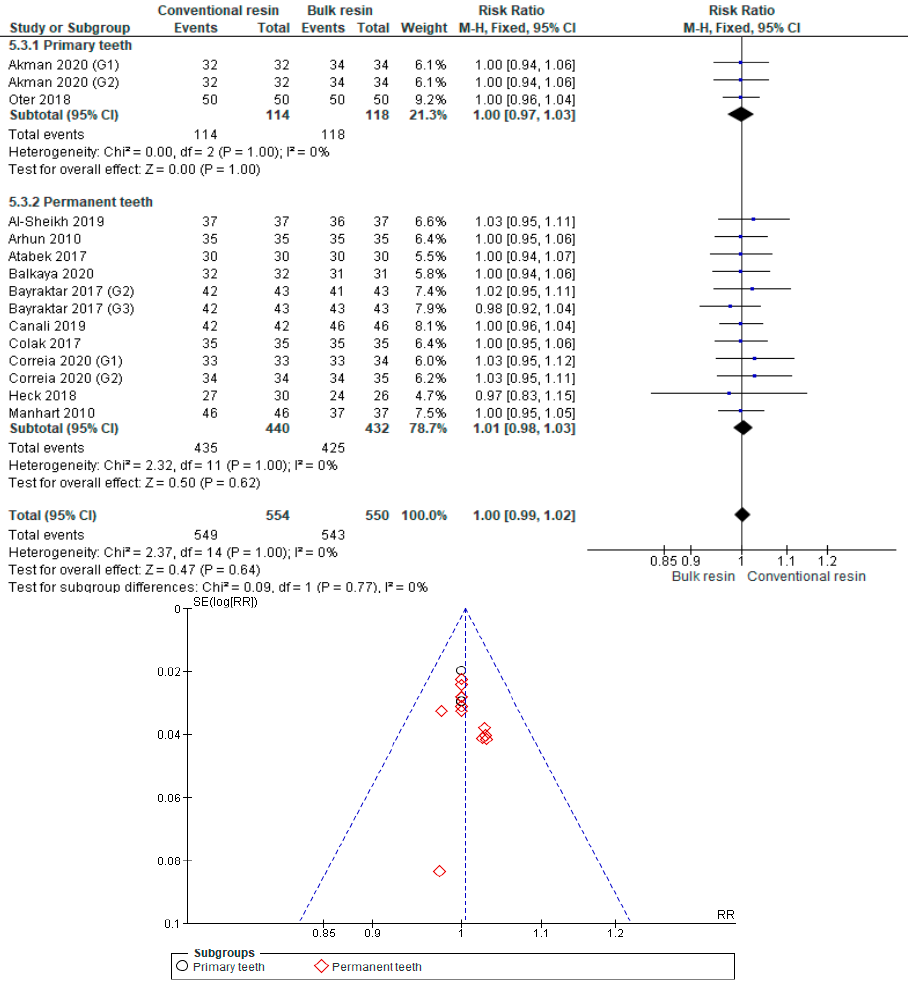
Figure A23. Absence of Secondary Caries: Conventional Resin versus Bulk Resin According to Type of Teething.